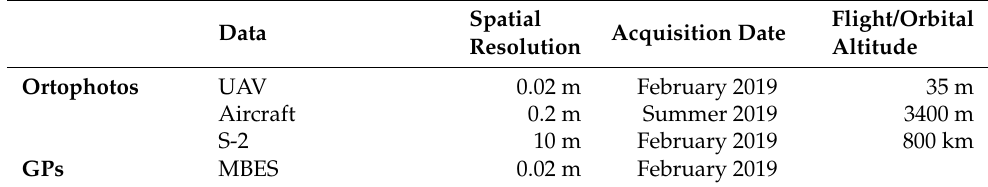
Table 2. Dataset description: spatial resolution and acquisition dates of orthophotos and GPs for